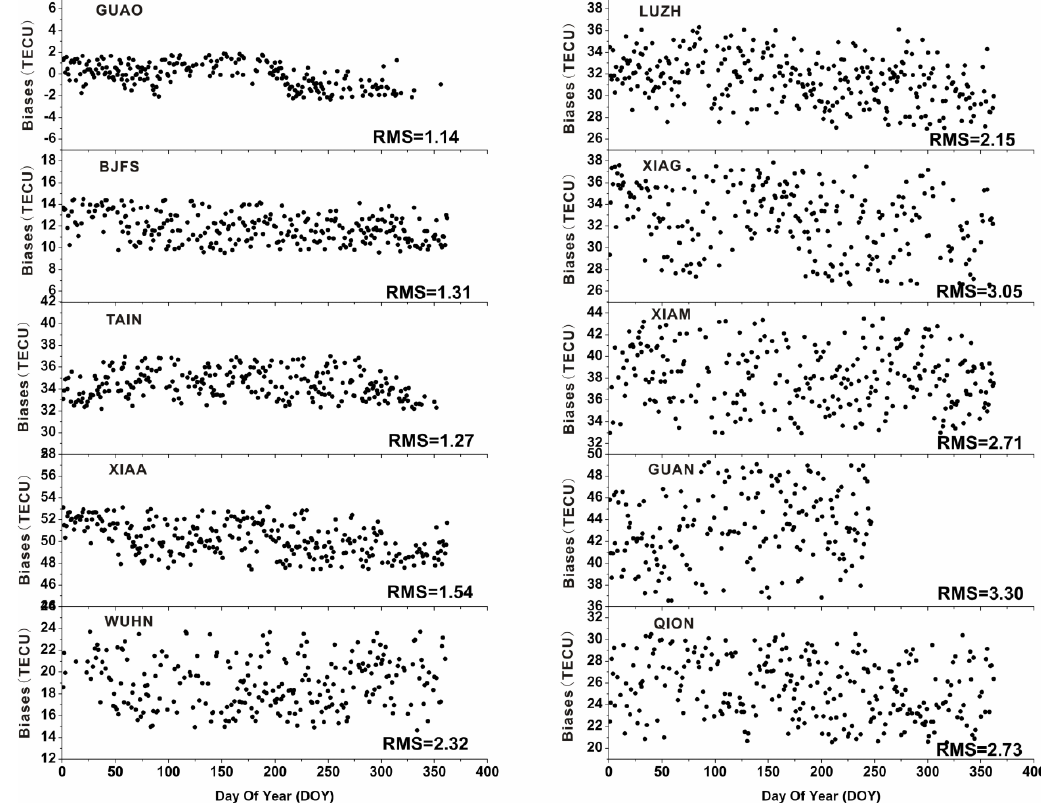
Fig. 6. Receiver instrumental biases estimated from GPS data in